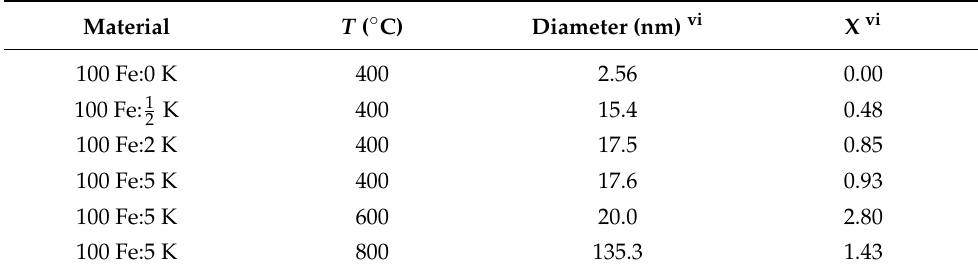
Table 3. The average diameter of α -Fe 2 O 3 particles and surface potassium content ( x ) for selected materials and calcination temperatures ( T